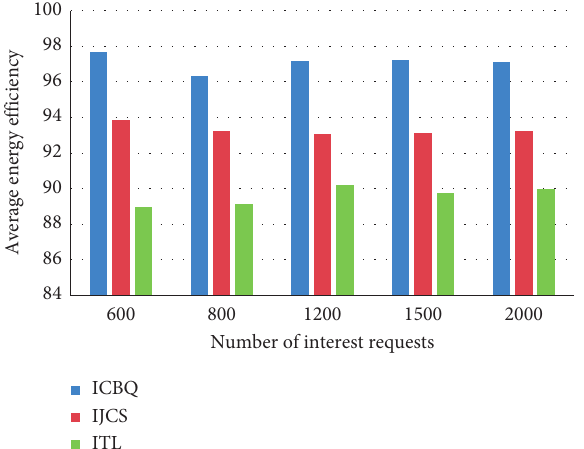
Figure 5: The average energy efficiency (%) among ICBQ, IJCS, and